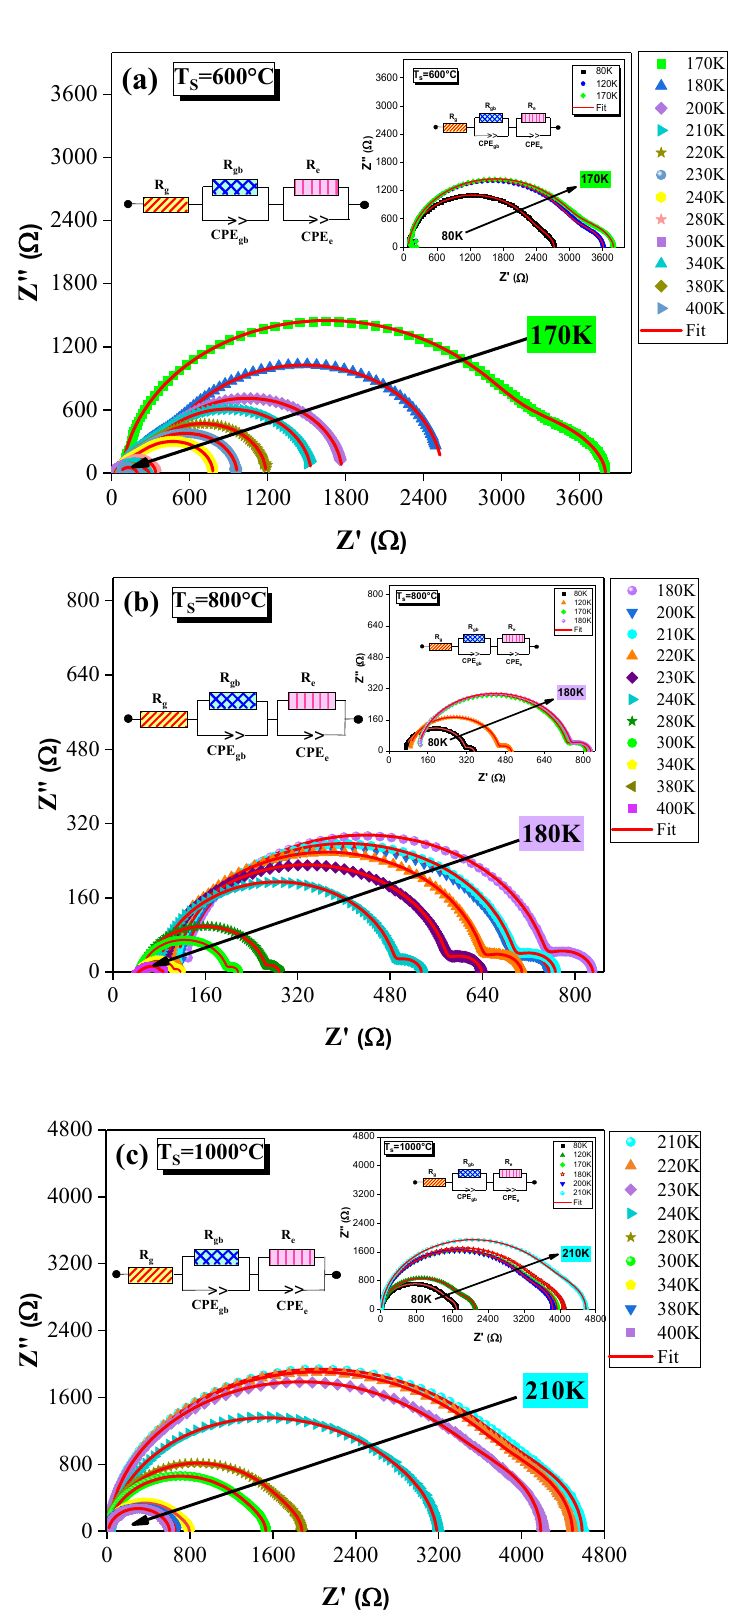
Figure 4. The Nyquist diagrams of La 0.9 Sr 0.1 MnO 3 system sintered at 600 °C ( a ), 800 °C ( b ), and 1000 °C ( c ).